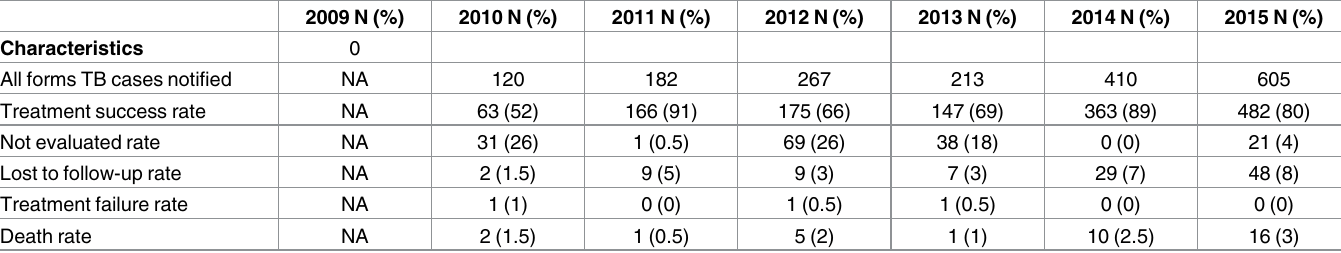
Fig 4. Treatment outcomes for SS+ TB, Kabul, 2009–2015. https://doi.org/10.1371/journal.pone.0178053.g004 Table 2. Treatment outcomes in private facilities,